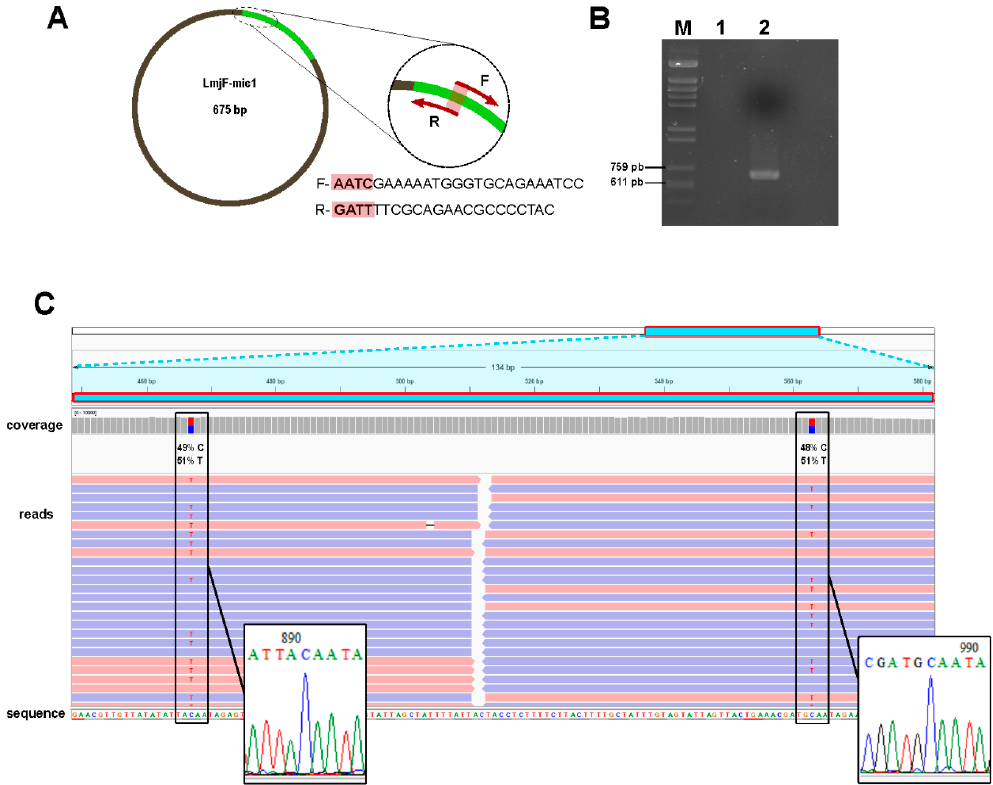
Figure 4. PCR validation of minicircle assemblies. ( A ) Primer design scheme based on the L. major minicircle 1 (LmjF-mic1). Primers F (forward) and R (reverse), shown as maroon arrows, were designed on the conserved region of the minicircle (green area). The primers overlap by 4-nt. ( B ) Analysis by agarose gel electrophoresis of the PCR amplification product (lane 2) and negative control (lane 1) contains the amplification in the absence of DNA template. Hin dIII-digested phi29-DNA was used as molecular weight marker (lane M) loaded; the length (in bp) of the marker bands with a size close to the amplification product are indicated on the left. ( C ) Alignment of Illumina reads on the sequence of clone 2 (one of the clones derived from the cloning of the amplicon shown in B). Two polymorphic sites (boxes) were identified and the frequency (in percentage) of the nucleotides found at those positions are shown. The insets at the bottom show the chromatogram of the sequence determined by the Sanger method in clone